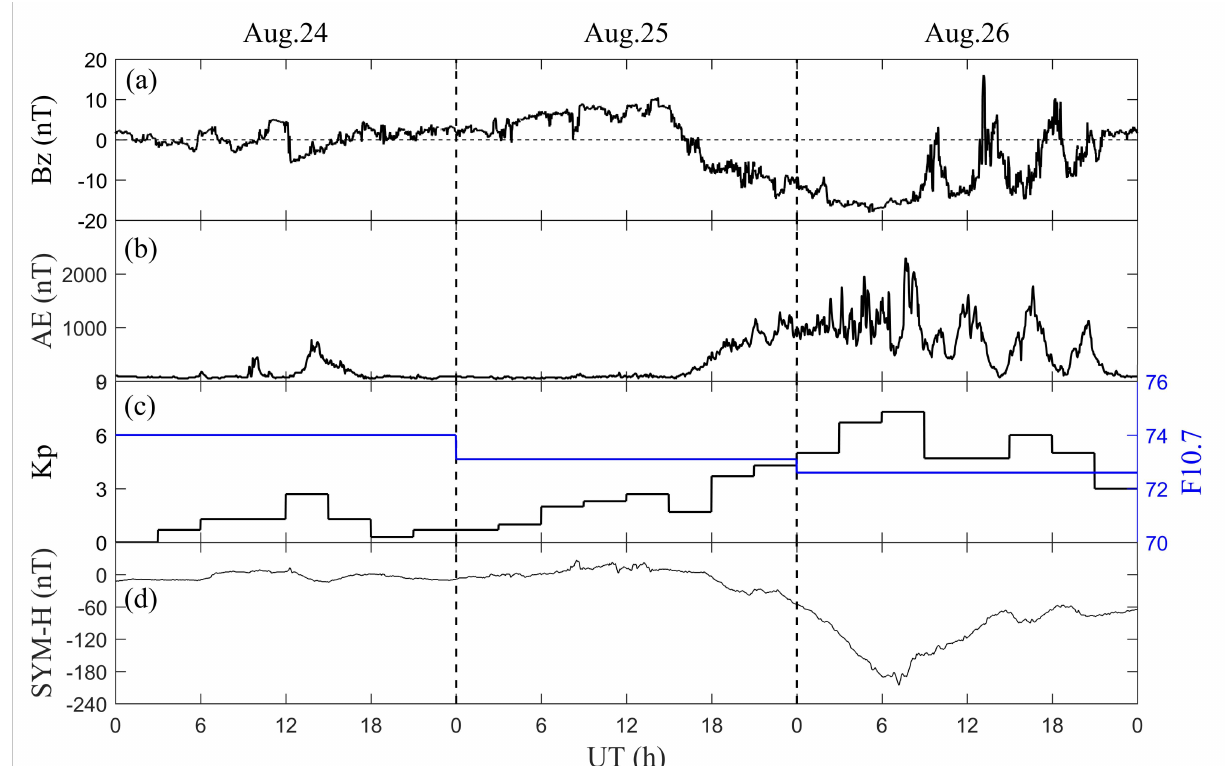
Figure 2. Time series of ( a ) IMF Bz, ( b ) AE index, ( c ) Kp index (dark line) and F10.7 (blue line), and ( d ) SYM-H index during the period of 24 − 26 August